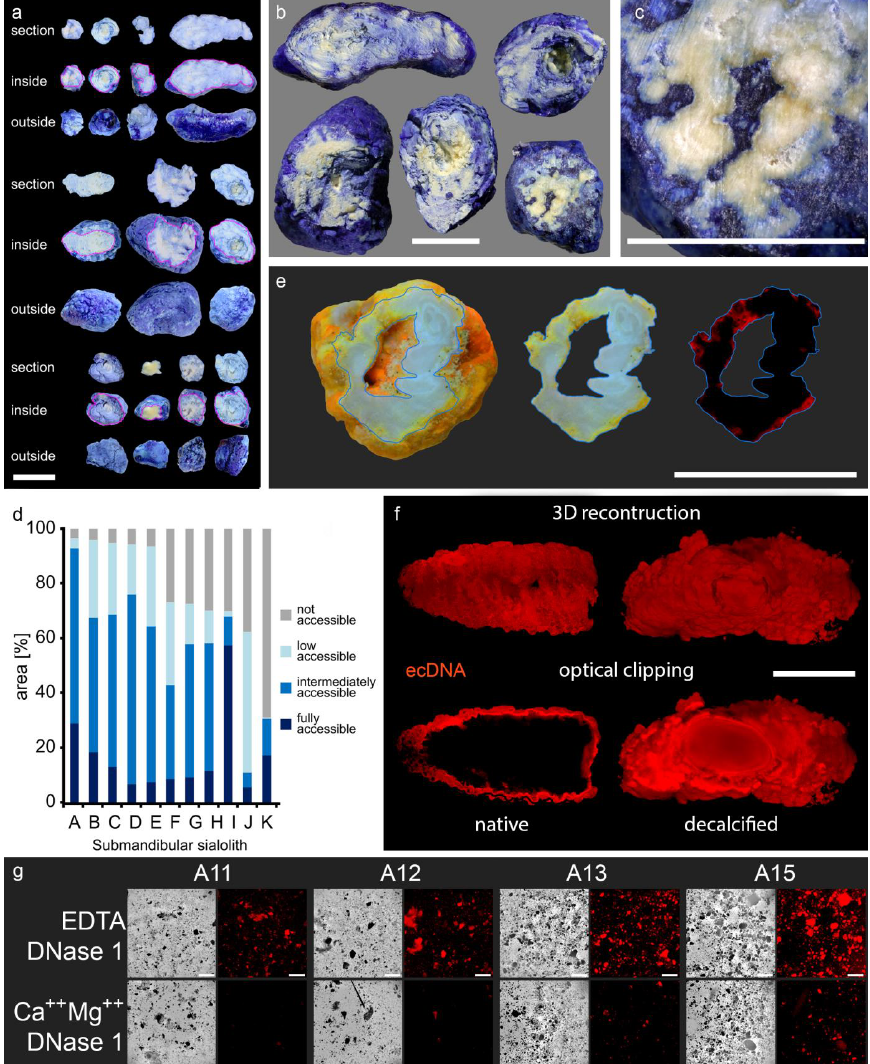
Figure 3. Sialoliths contain dye-impermeable, densely calcified areas and extracellular DNA (ecDNA). Stones were immersed in different dyes and subsequently ground to reveal their interior. The calcified surface is very compact and prevents the penetration of all employed dyes into the stones´ interior.